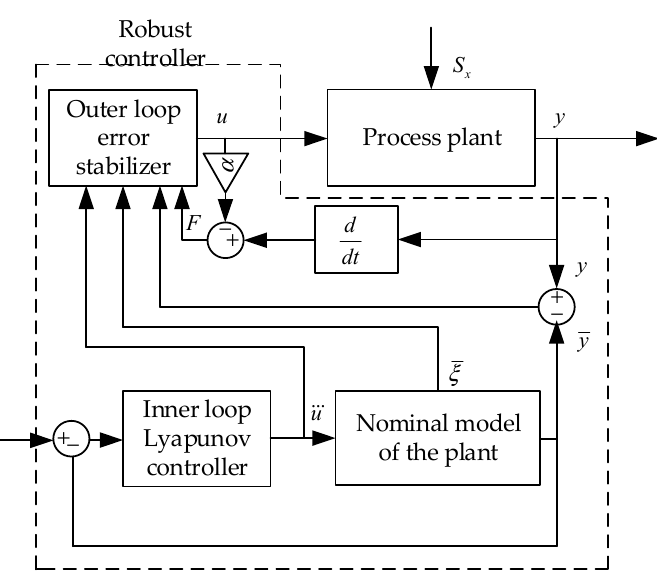
Figure 10. Robust Lyapunov controller for uncertain systems.